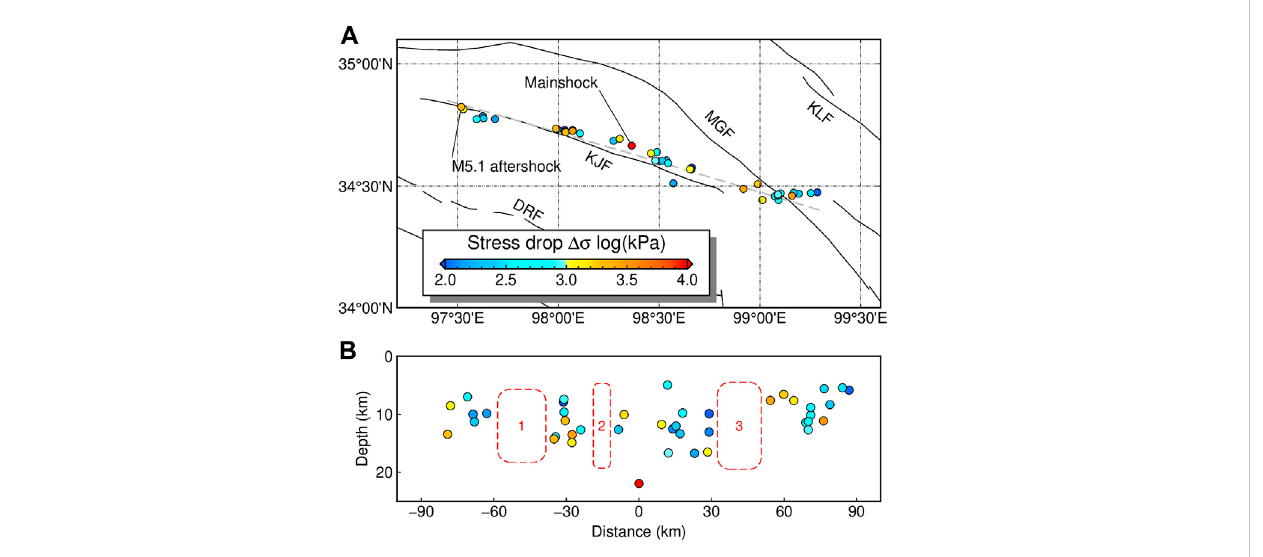
FIGURE 10 (A) Map view and (B) depth cross-section of the stress drops for the 21 May 2021 Maduo earthquake sequence. The fi lled circles illustrate the relocated